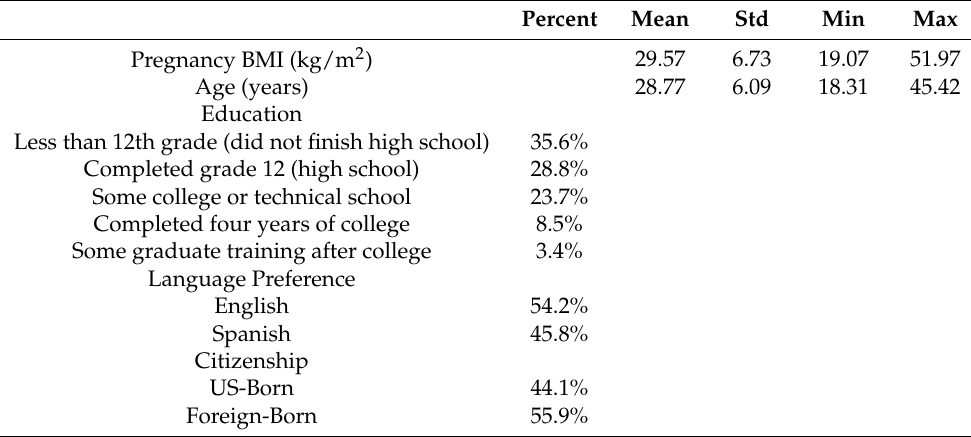
Table 1. Demographic Descriptive